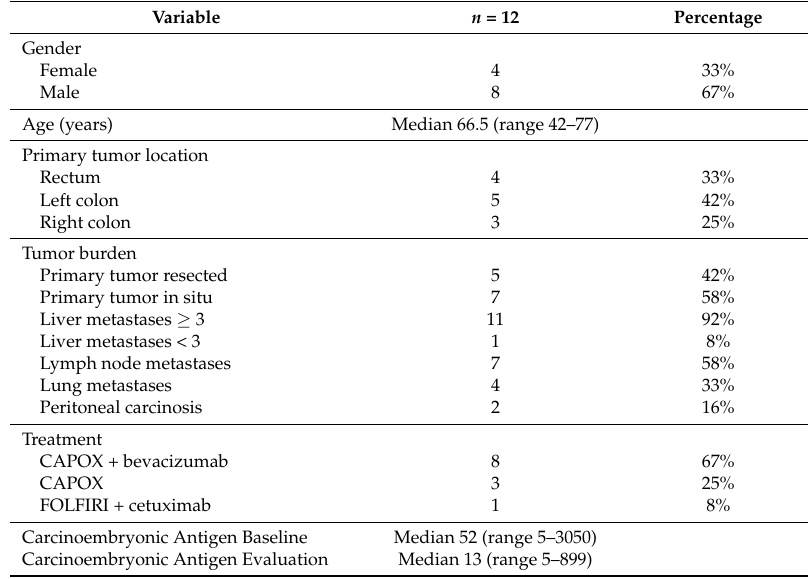
Table 1. Patient characteristics.